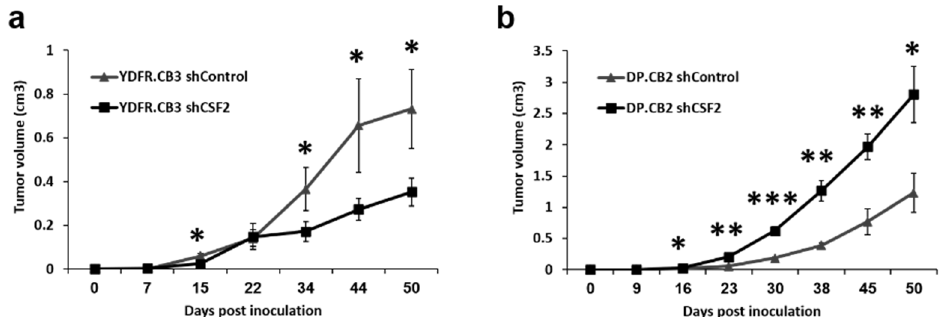
Figure 5. GM-CSF promotes or inhibits local tumor formation by different melanoma cells. ( a,b ) Nude mice were inoculated SC with GM-CSF silenced (shCSF2) or control (shControl) YDFR.CB3 and DP.CB2 cells ( n = 8 in each group). Tumor dimensions of cutaneous tumors established from YDFR.CB3 ( a ) and DP.CB2 ( b ) cells were measured using a caliper and volume was obtained as described in Materials and Methods. The average tumor volume + SEM is presented. * p < 0.05, ** p < 0.001, *** p <